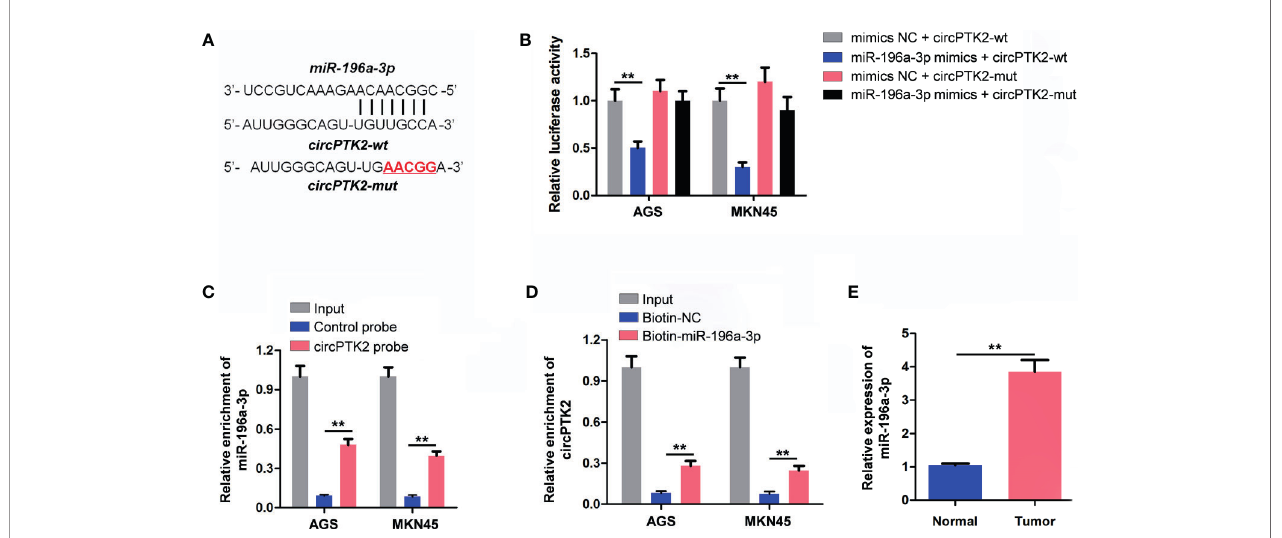
FIGURE 5 | CircPTK2 acts as the sponge of miR-196a-3p. (A) Schematic diagram of binding sites between circPTK2 and miR-196a-3p. (B) Luciferase activity analysis in AGS and MKN45 cells co-transfected with the circPTK2-wt/mut vectors together with miR-196a-3p mimics or mimics control. (C, D) RNA pull-down assay was performed in AGS and MKN45 cells to verify the binding between circPTK2 and miR-196a-3p. (E) RT-qPCR analysis of miR-196a-3p level in tumor tissues and in normal tissue. ** p < 0.01. The signi fi cance between two or more groups was analyzed by Student ’ s t -test or one-way ANOVA, respectively.